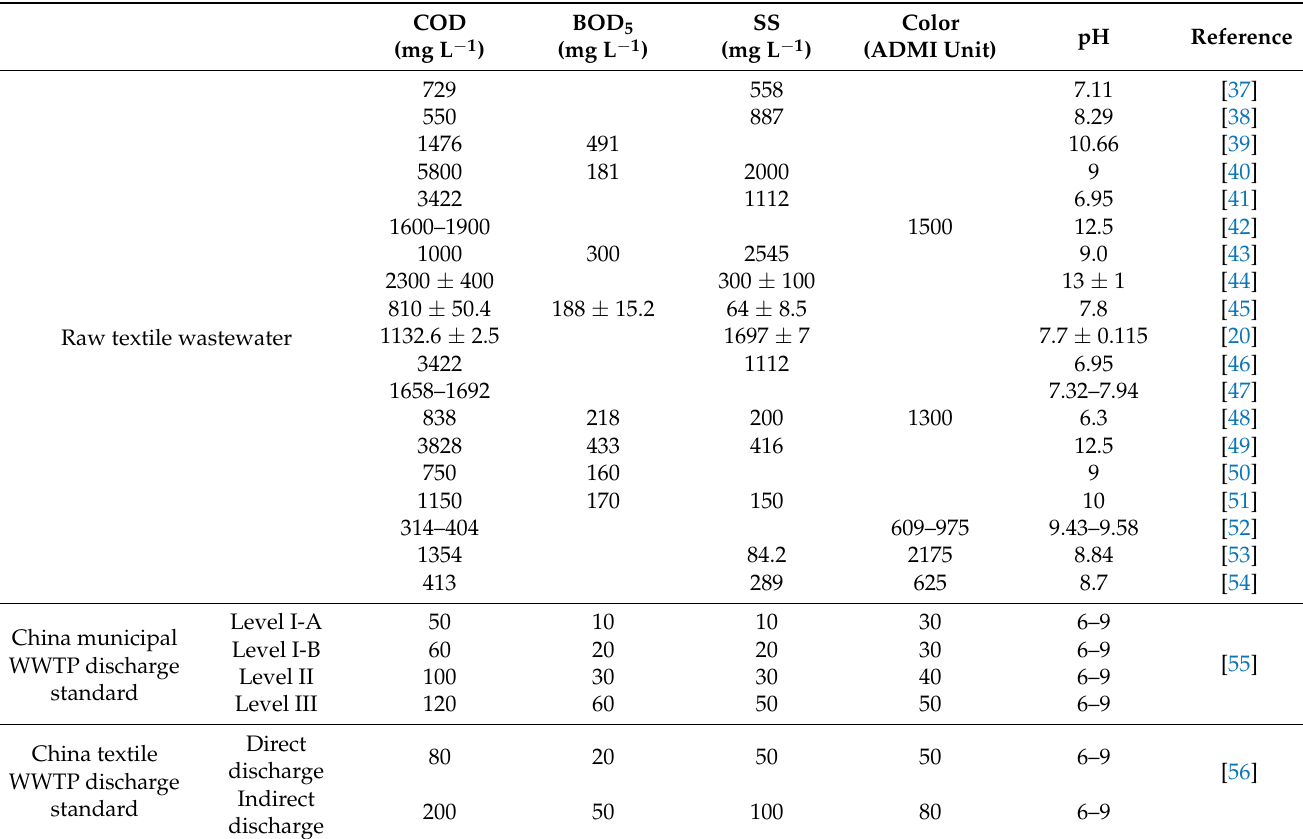
Table 1. Characteristics of raw textile wastewater from recent studies and discharge standards of major pollutants for municipal wastewater treatment plants in China.